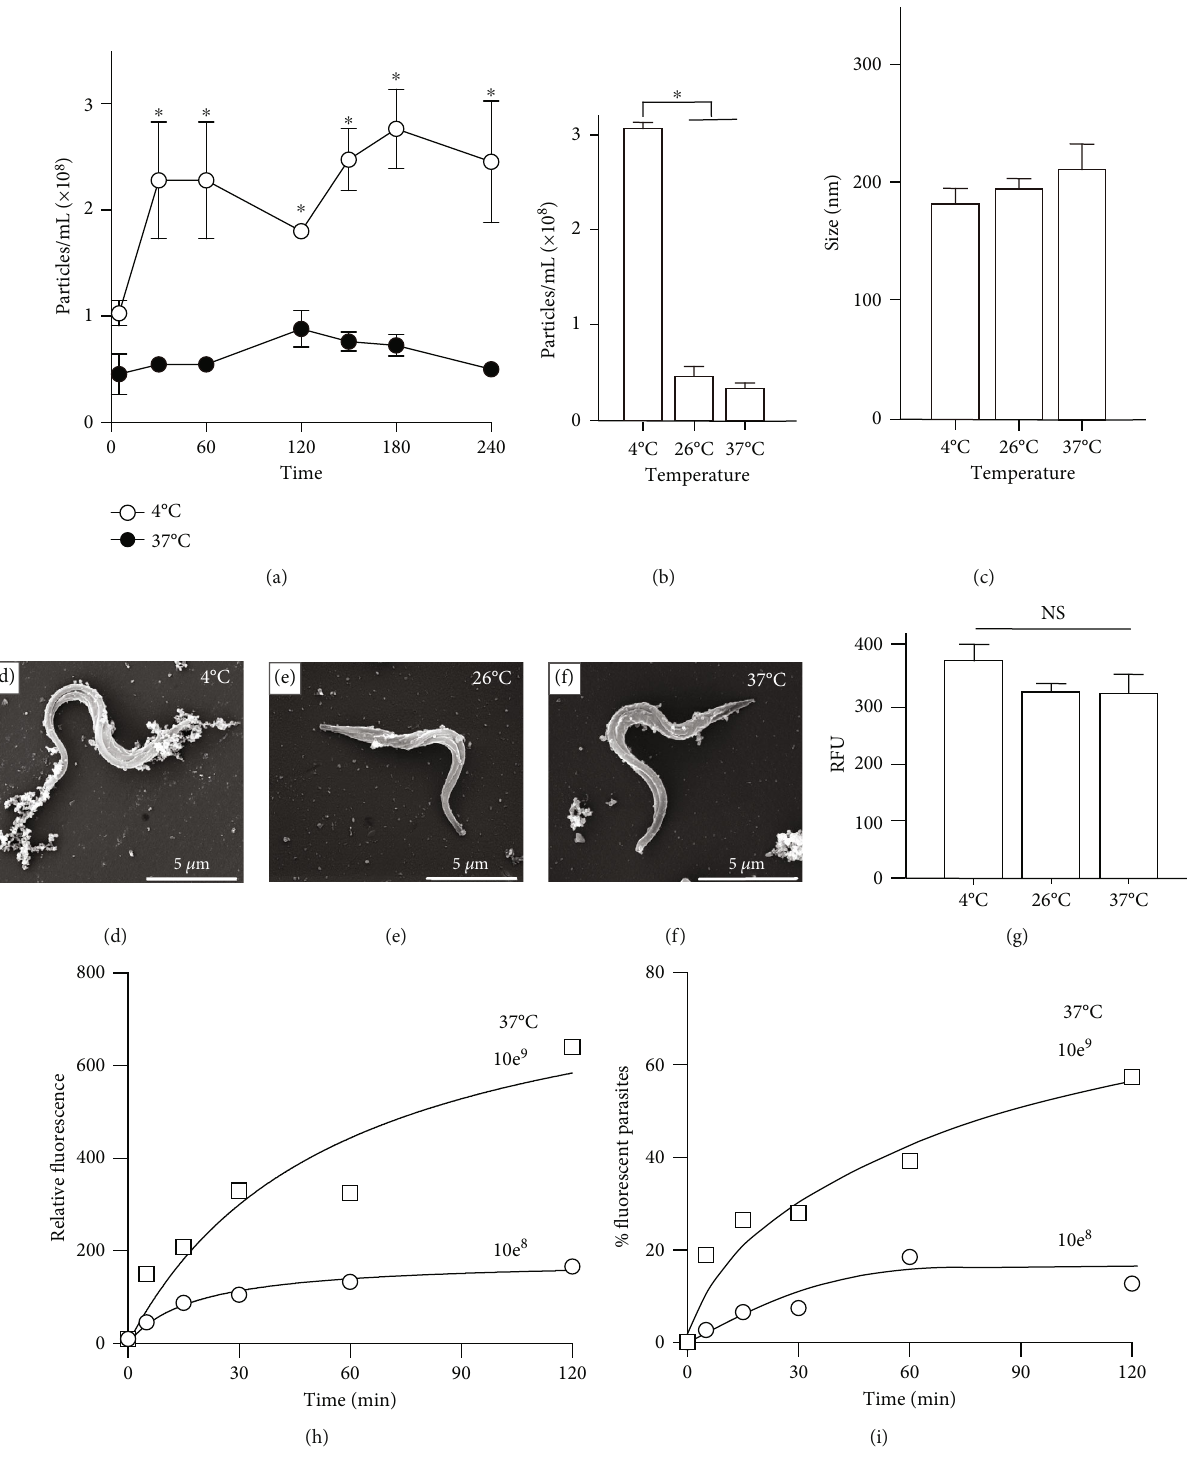
Figure 1: Kinetics of EV release by T. cruzi trypomastigote forms. 1 × 10 7 trypomastigotes were incubated in DMEM supplemented with 5% glucose at di ff erent temperatures. EV concentrations were determined at di ff erent time points by NTA (see Material and Methods). The panels show total EV concentration (a, b) and particle size (c) in the supernatants after 2 h of incubation at di ff erent temperatures ( ∗ < 0.05). SEM images of trypomastigotes incubated for 2h at 4 ° C (d), 26 ° C (e), and 37 ° C ((f), size bars = 5 μ m). Panel (g) indicates the correspondent relative fl uorescence (RFU) of PrestoBlue viability reagent (mean and standard deviation, n = 3 ) showing no signi fi cant (NS) di ff erences ( p > 0 : 05 ). EVs labeled with PKH26 ( 1 × 10 8 /mL and 10 9 /mL) were incubated with 1 × 10 7 trypomastigotes/mL (37 ° C). The parasites were collected at di ff erent time points, and the median of fl uorescence (h) or the percentage of labeled parasites (i) was evaluated by fl ow cytometry. Results are average values in triplicate